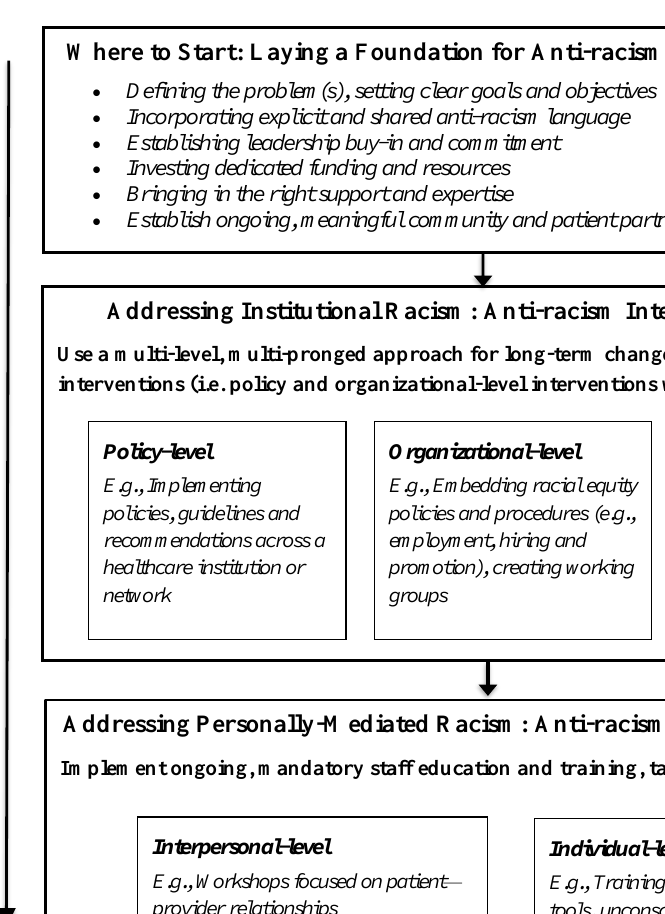
Figure: Overview of the principles and strategies for anti-racism interventions in healthcare settings